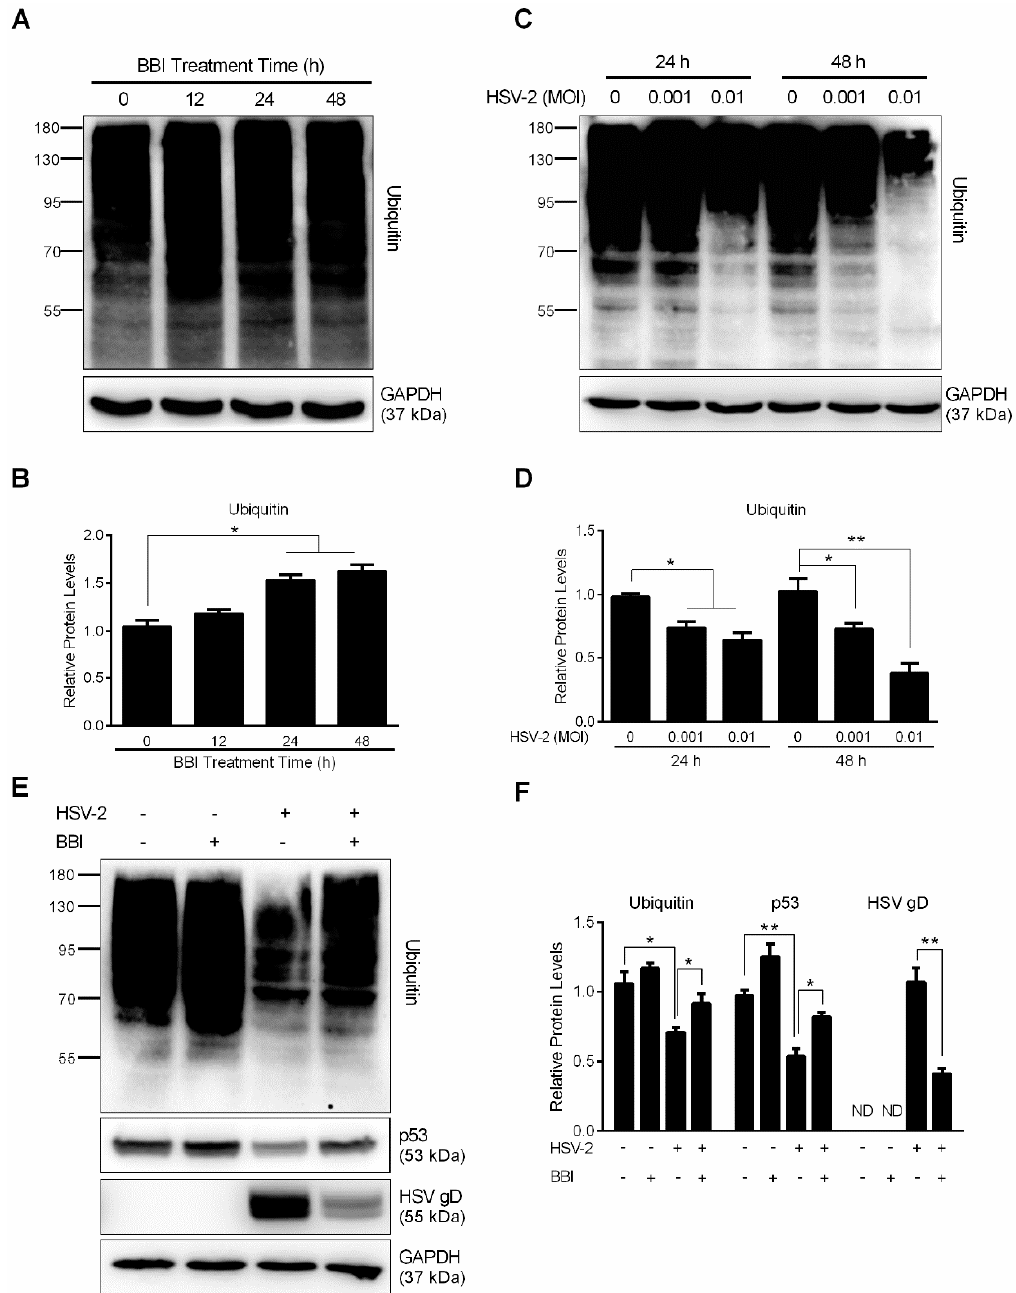
Figure 5. Effect of BBI on HSV-2-induced degradation of ubiquitinated proteins. ( A ) End1/E6E7 cells were treated with BBI for indicated times. ( C ) End1/E6E7 cells were infected with HSV-2 at the indicated MOI, and proteins were collected from the infected cells at 24 h or 48 h PI. ( E ) End1/E6E7 cells were pretreated with or without BBI for 24 h, then infected with HSV-2 (MOI of 0.001) for 2 h, and then cultured with or without BBI. Proteins were subjected to Western blot with the antibodies against ubiquitin, p53, HSV gD or GAPDH. Representative data from three independent experiments were shown. ( B , D , F ) Densitometry analysis of the blots shown in A, C, and E was performed with ImageJ 1.44 software. Data shown were obtained as mean ± SD from three independent experiments (* p < 0.05, ** p < 0.01).